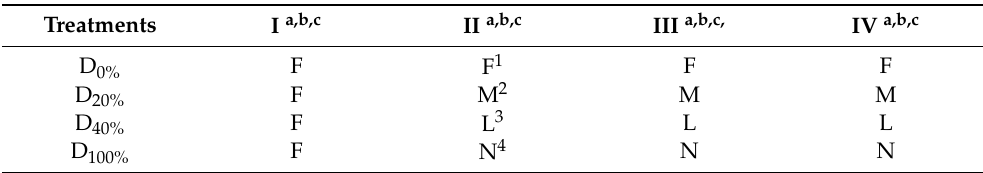
Table 1. Different irrigation treatments at different growth stages for the experiments during three growth seasons from